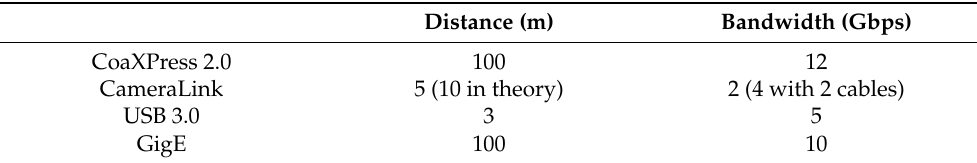
Table 1. Primary camera